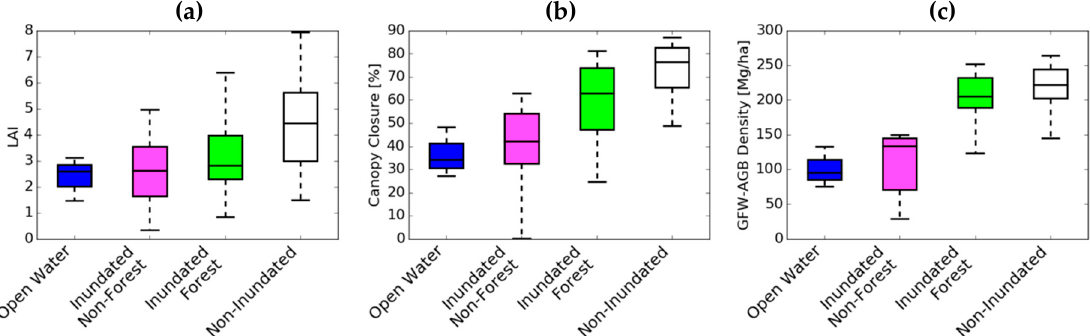
Figure 17. Distribution of vegetation structure metrics of transect points that showed evidence of seasonal flooding, grouped by PALSAR-2 maximum flooded extent class: ( a ) LAI; ( b ) canopy closure; ( c ) GFW-AGB density.